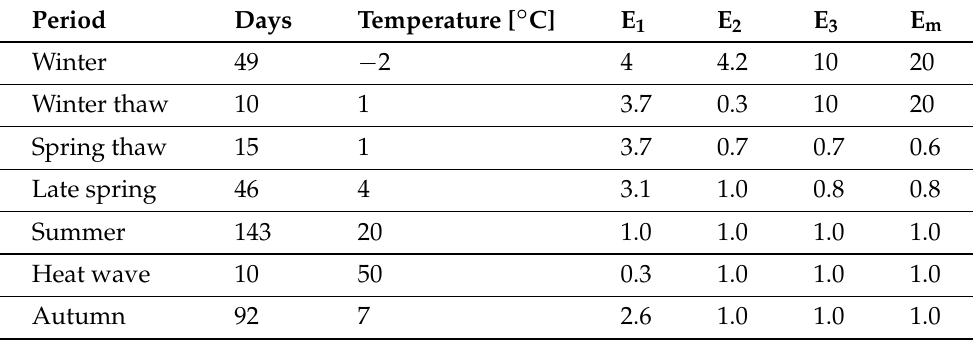
Table 4. Seasonal variation in the bearing capacity in a road construction from MMOPP 2017, pavement design